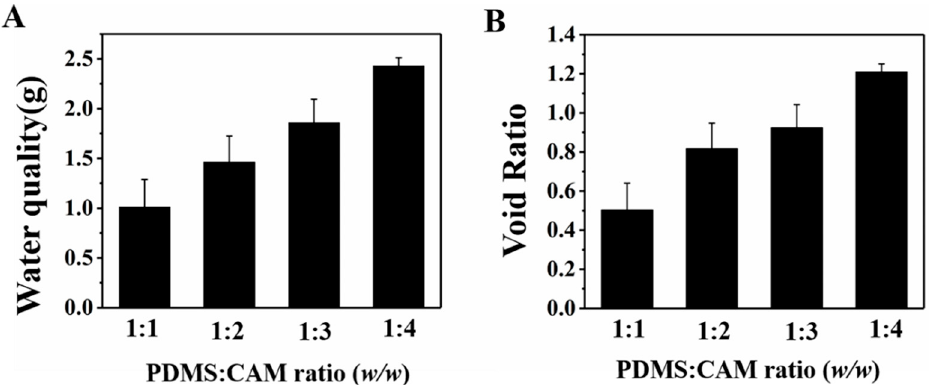
Figure 4. Water content of PDMS sponges. ( A ) The maximum water content of PDMS sponges. ( B ) Void ratio of PDMS